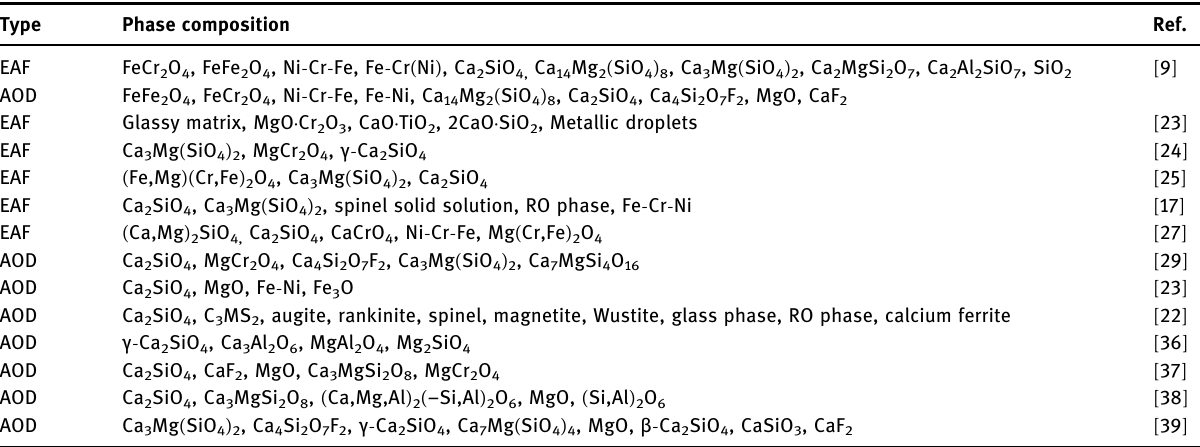
Table 3: Mineral phase composition of stainless steel slag